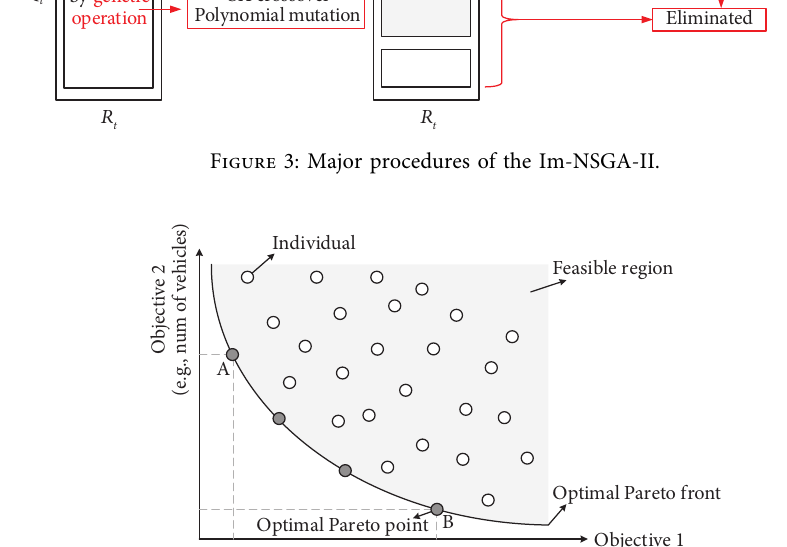
Objective 1 (e.g., operating